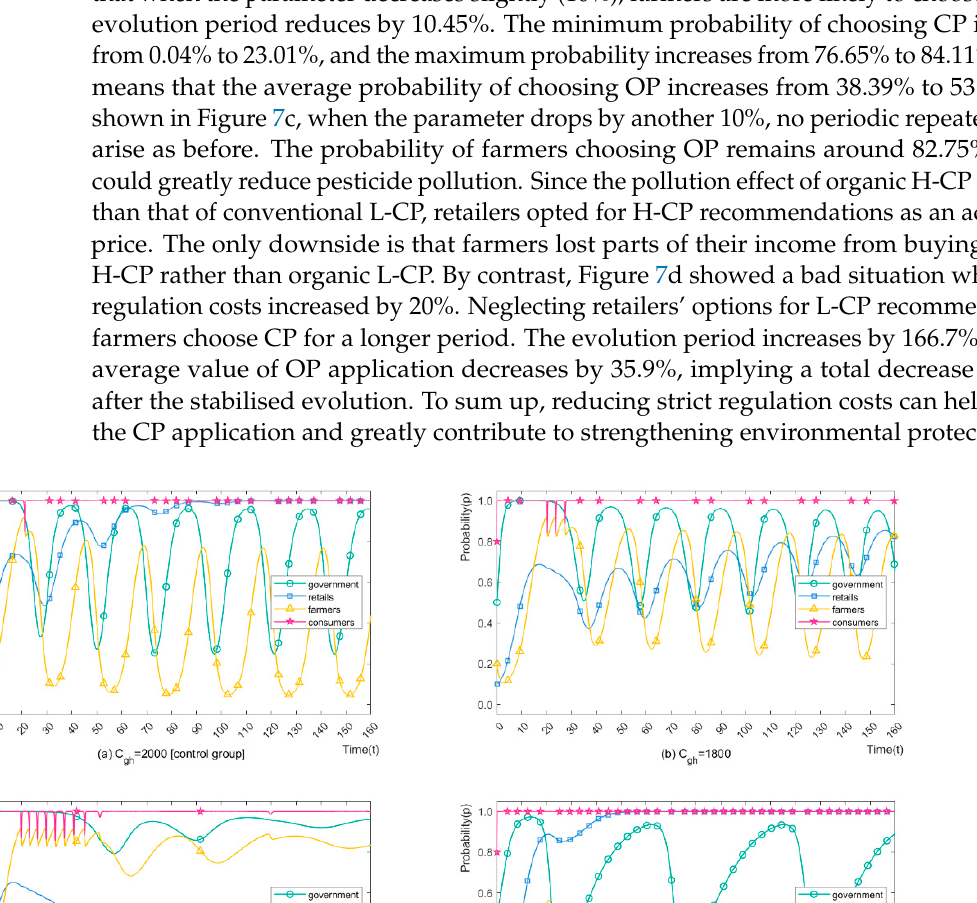
Figure 7. The Strategies Evolution Process of Stakeholders with Different